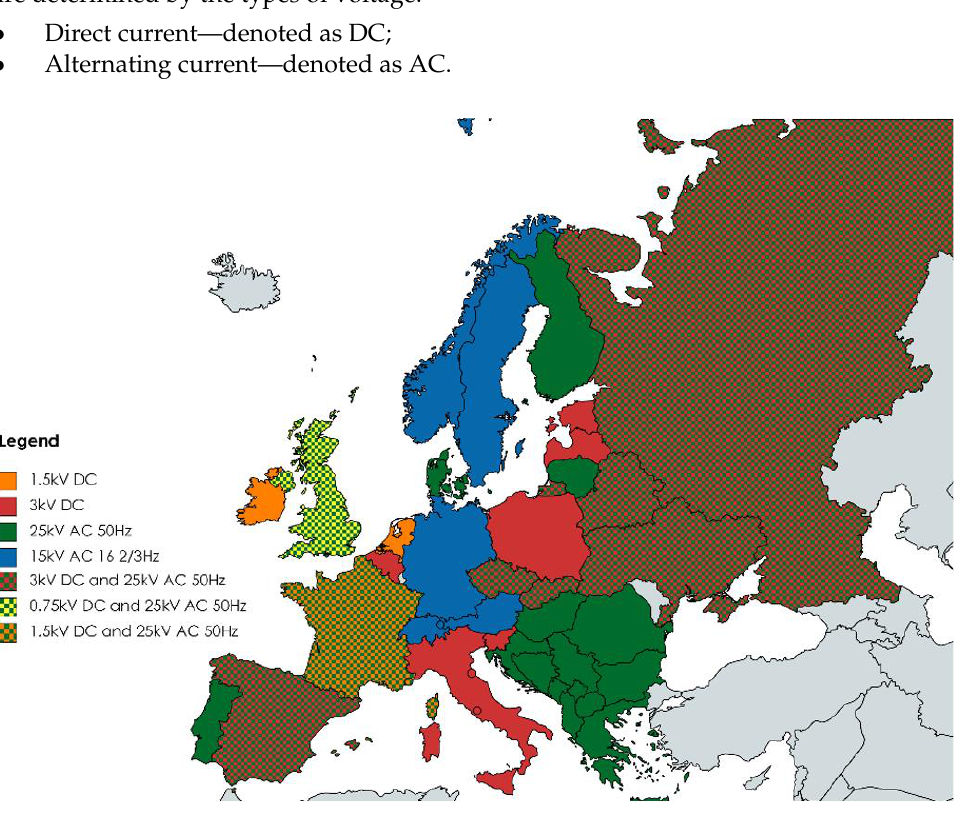
Figure 1. Rail transport electro-energy systems in European countries, the general condition. Then, the system is characterised by the value and frequency (possibly the number of phases) of the voltage in the